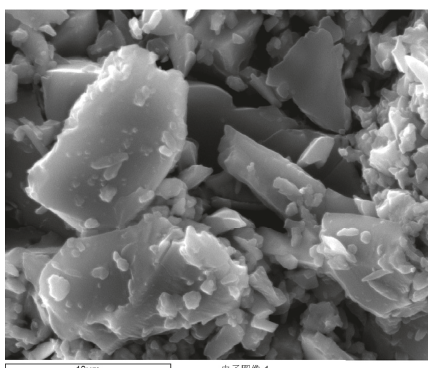
Figure 3: SEM photo of phosphorus slag powder (ruler 10 μ